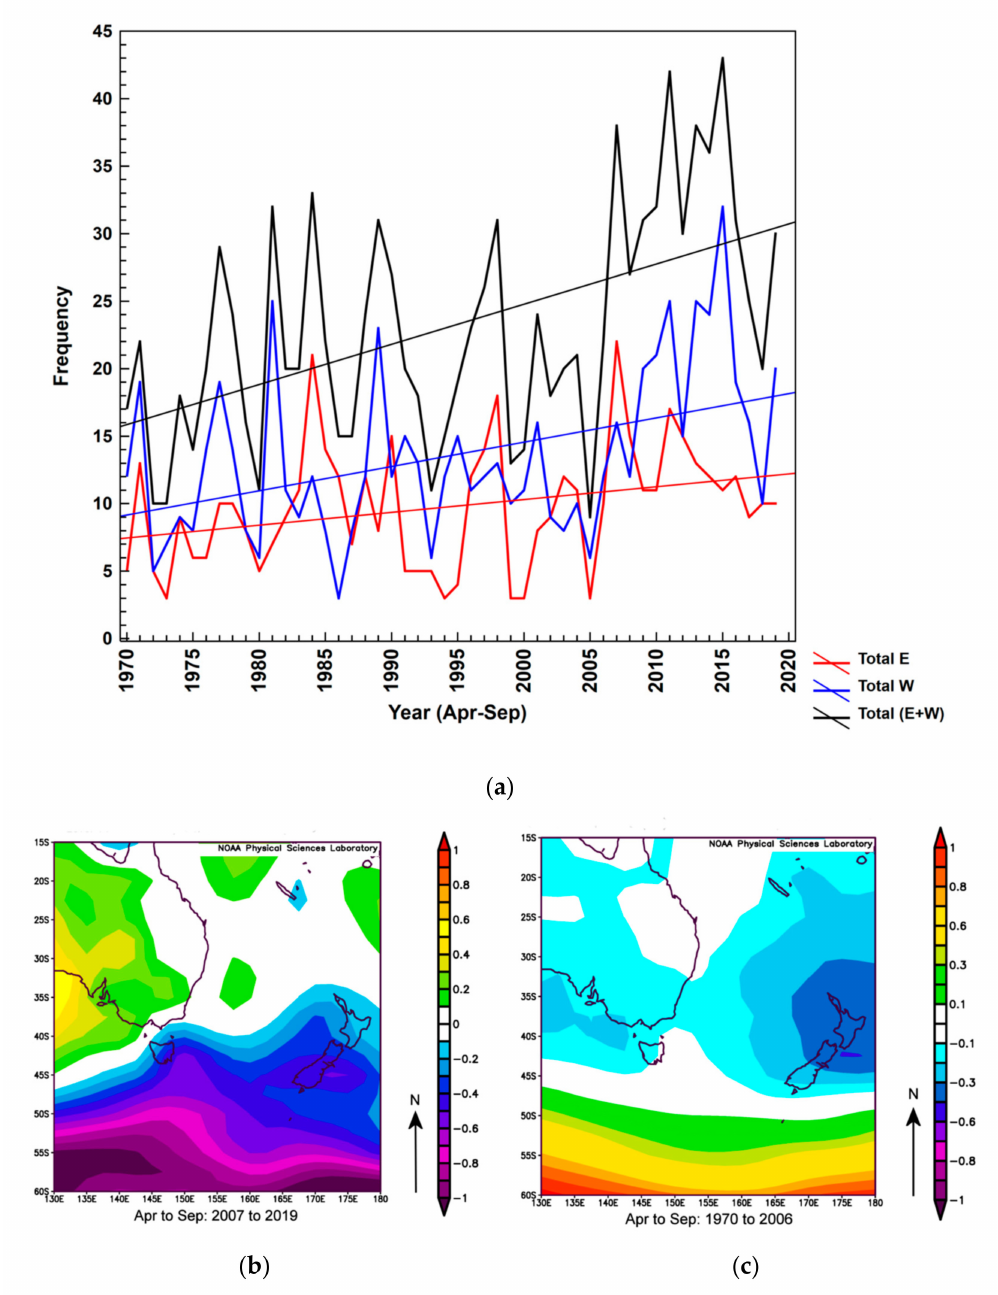
Figure 2. ( a ) Frequencies 1970–2019 (April–September) of synoptic categories of Total ECLs:- Total Easterly (Total E); Total Westerly (Total W); Total (E+W). Linear trends for each category are indicated. ( b ) NCEP/NCAR reanalysis of MSLP anomalies (hPa) 2007–2019 (April–September). ( c ) NCEP/NCAR reanalysis of MSLP anomalies (hPa) 1970–2006. Image provided by the NOAA/ESRL Physical Sciences Laboratory, Boulder Colorado from their Website at: http://psl.noaa.gov/ (accessed on 10 February 2021)